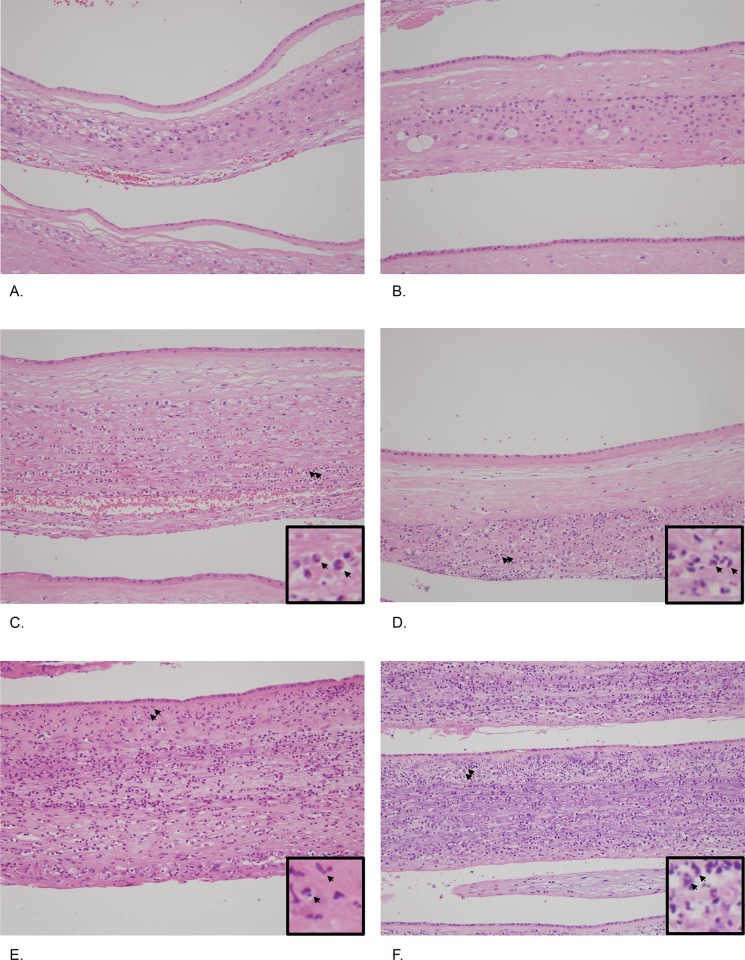
Histopathology of extra-placental membranes (chorio-decidua and amnion) (These images are based on the magnification setting X200).Hematoxylin and eosin stained histologic sections of extra-placental membranes (chorio-decidua and amnion) are shown for inflammation-free placenta (A, PTL; and B, preterm-PROM), choriodeciduitis only (C, PTL; and D, preterm-PROM) and chorio-deciduitis with amnionitis (E, PTL; and F, preterm-PROM). Neutrophils in the chorio-decidua are indicated with arrows in panel C and panel D (see insets of panels C-D), and arrows in panel E and panel F indicate neutrophilic infiltration in amnion (see insets of panels E-F).